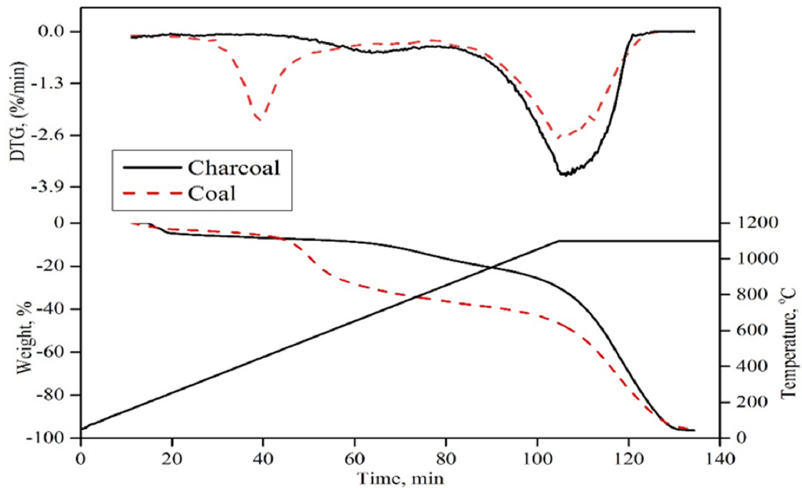
Figure 4. Gasification of charcoal and coal in CO 2 atmosphere up to 1100 °C. Table 3. Behaviors of charcoal and coal in CO 2 atmosphere heating up to 1100 °C from the room temperature.